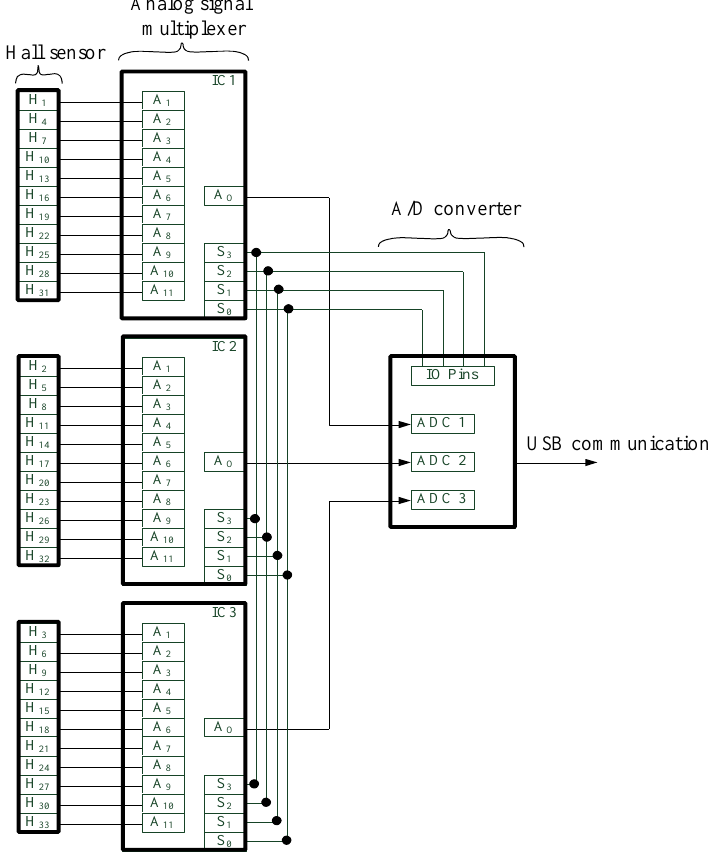
Figure 4. Connection of 1-D Hall sensor signals to analog